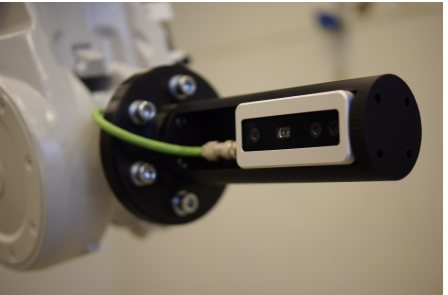
Figure 3. FRAMOS D415e Camera and its bespoke support. The cameras are referred to as left/right/up and front/back. The left/right is defined in relation to the CHU, not to the pig, which can be rotated once grabbed by the CHU. TThe left, right, front, and back sides of the CHU were defined as shown in Figure 4.